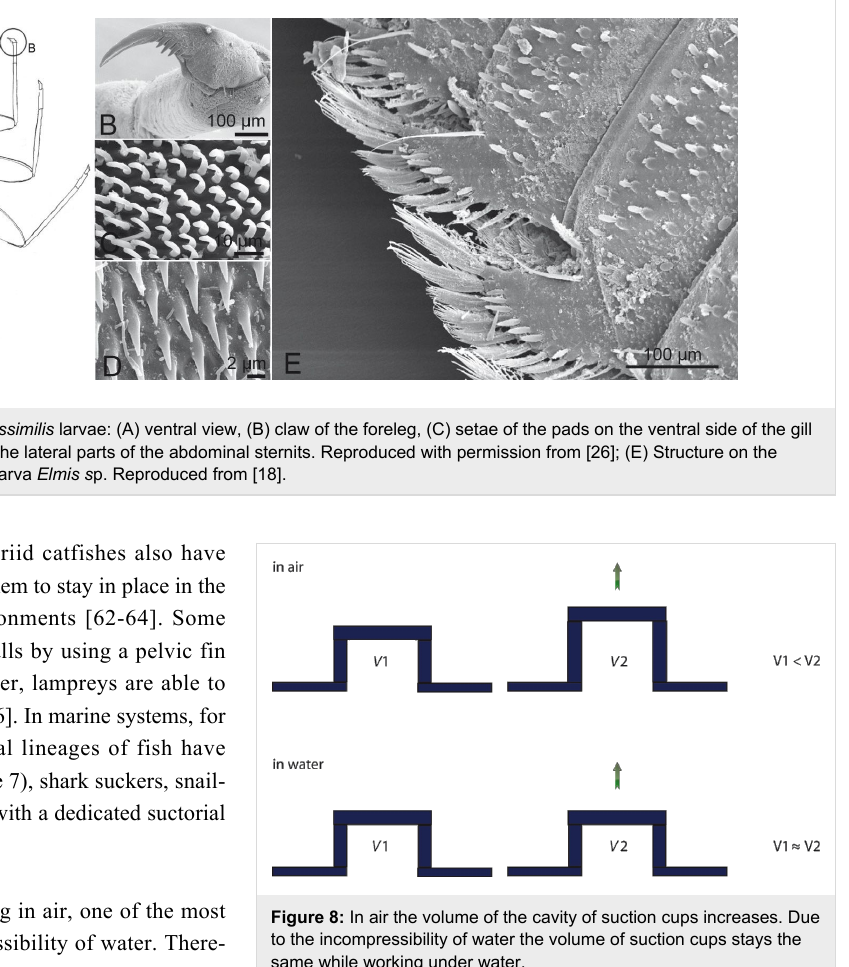
However, the pressure measured under an octopus sucker went negative in 35% of the cases and the lowest pressure measured was 0.168 MPa [72]. The same study shows that seawater